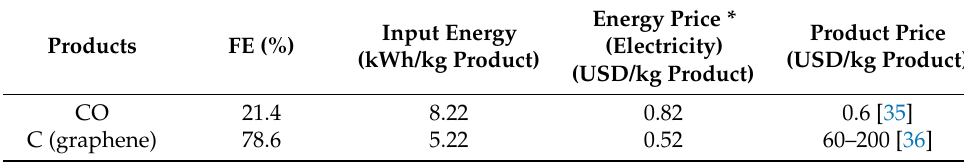
Table 3 . Faradaic efficiency, power consumption, and the market price of the products obtained from